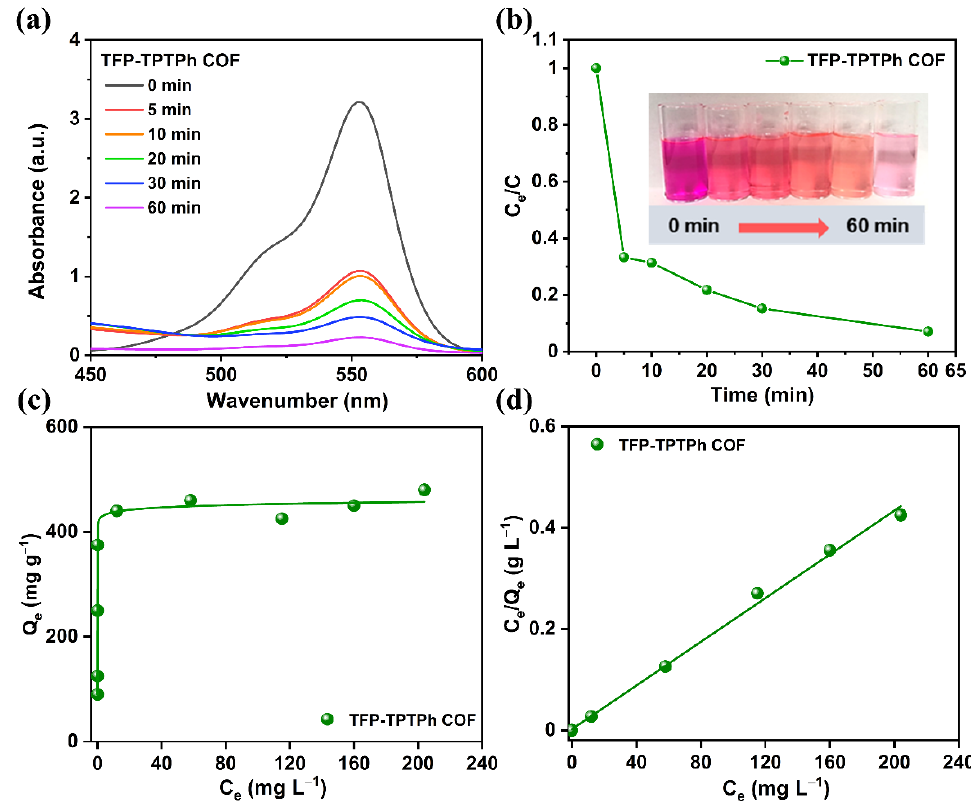
Figure 4. ( a ) UV – Vis spectra of an aqueous RhB solution (10 mL, 18 mg L −1 ) at various time intervals (from 0 to 60 min) after the addition of TFP-TPTPh COF (4 mg), all measurements were carried out at 25 °C, stirring speed = 800 rpm, pH = 7. ( b ) Rates of adsorption of RhB (10 mL, 18 mg L −1 ) onto the TFP- TPTPh COF (4 mg), all measurements were carried out at 25 °C, stirring speed = 800 rpm, pH = 7. ( c ) Langmuir isothermal model and ( d ) adsorption isothermal curve for the adsorption of RhB (10 mL, from 12.5 to 200 mg L – 1 ) onto TFP-TPTPh COF (4 mg), all measurements were carried out at 25 °C, stirring speed = 800 rpm, stirring time = 24 h, pH = 7.